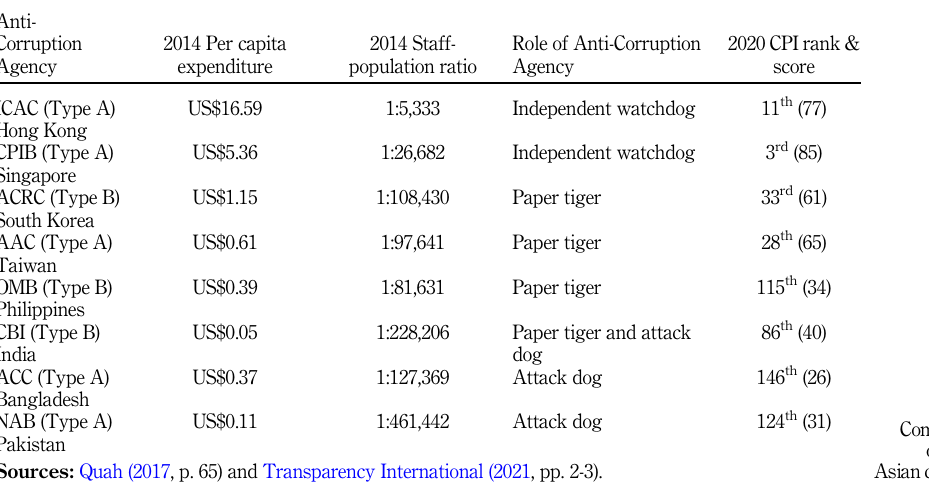
Table 6. Comparing the roles of ACAs in eight Asian